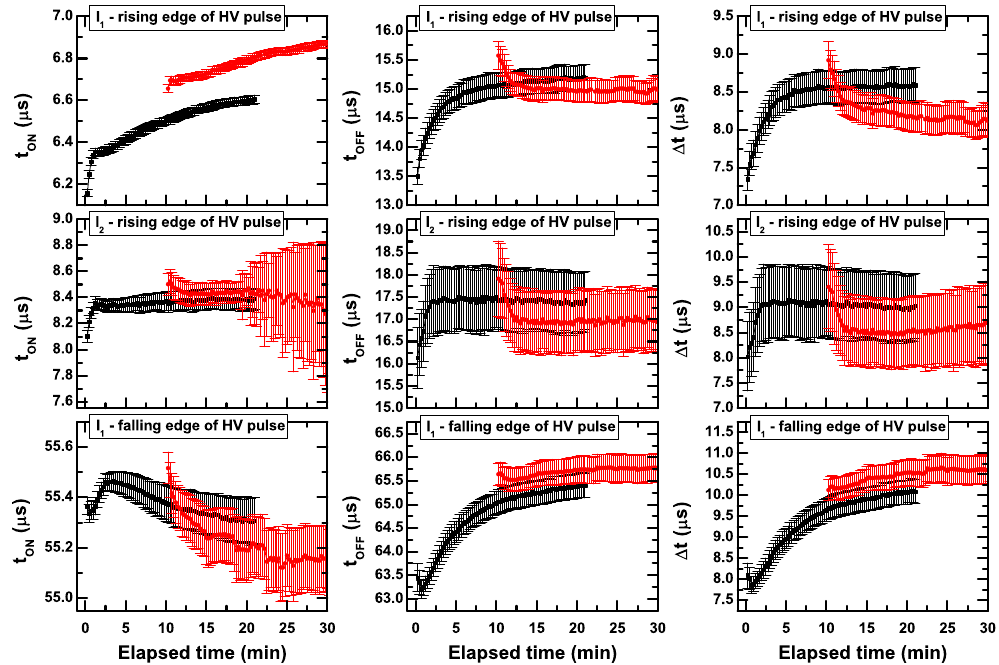
Figure 4. Influence of elapsed time on ignition ( t ON ) and extinction ( t OFF ) time and current pulse duration ( ∆ t = t OFF − t ON ) (pulse parameters and graphical details are the same as in Figure